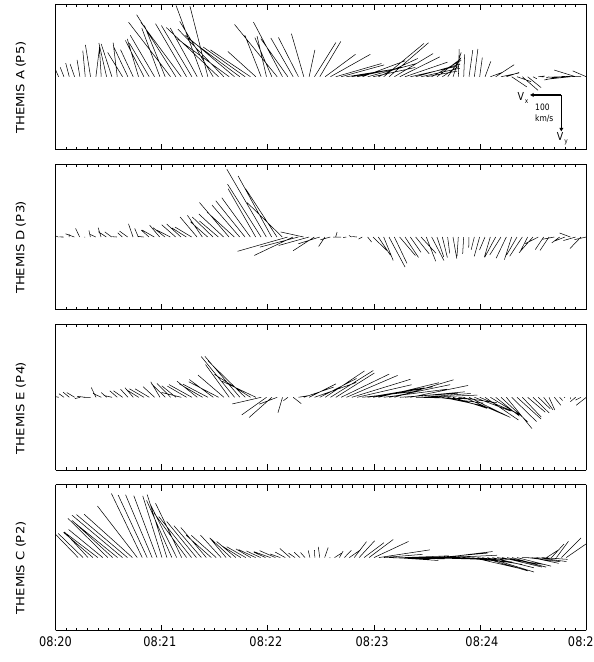
Fig. 4. Vector plots of the flow velocities (projected onto the GSM X-Y plane) for four THEMIS satellites (P2, P3, P4, and